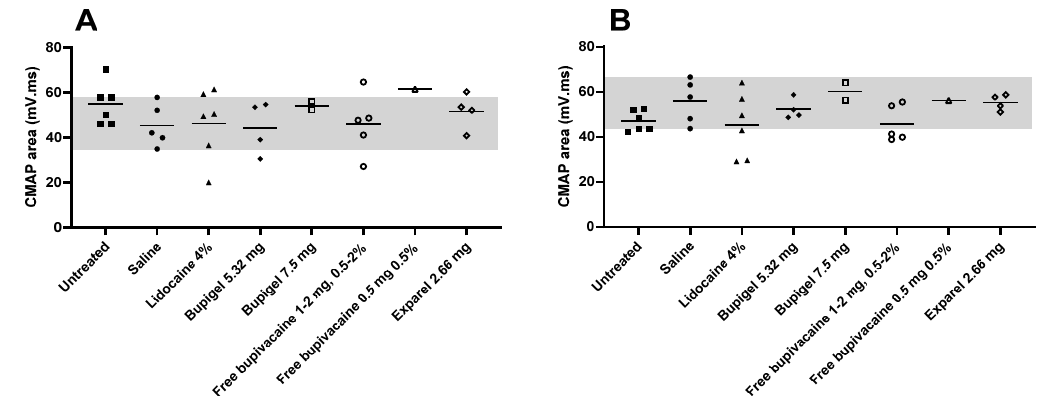
Figure 5. Effect of the different formulations on distal CMAP areas. Individual tibial ( A ) and peroneal ( B ) CMAP area values were measured two weeks after the perineurial administration of the different formulations. The gray area in the background indicates the range of values obtained in the saline group. Saline n = 5, lidocaine 4% n = 6, Bupigel 5.32 mg n = 4, Bupigel 7.5 mg n = 2, free bupivacaine 0.5 mg at 0.5% n = 1, free bupivacaine (1–2 mg at 0.5–2%) n = 5 (1 limb per dose and concentration tested), Exparel ® n = 4, untreated/naïve n = 6.